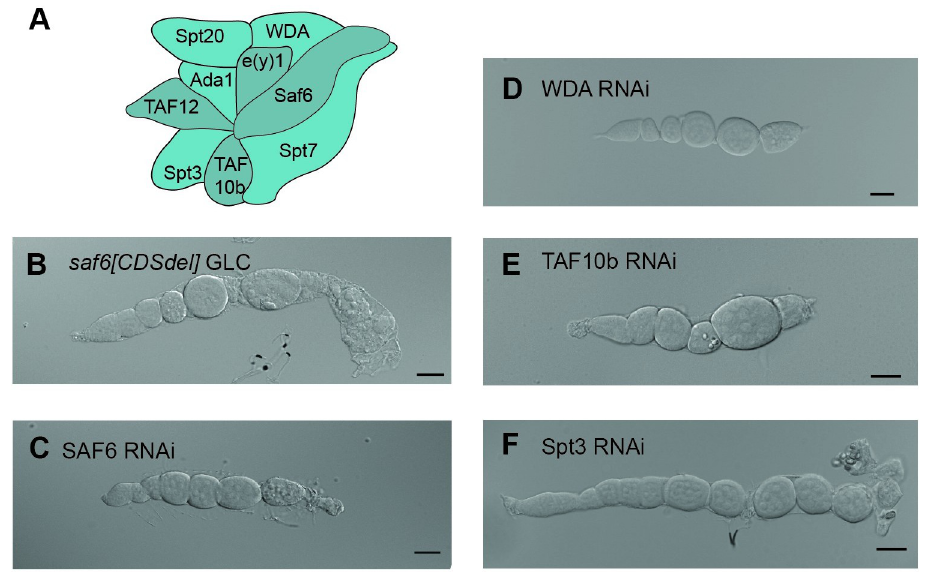
Fig 2. The core module of the SAGA complex is required for mid-oogenesis. (A) Overview of SAGA core subunits. (B) saf6[CDSdel] ovariole. (C) SAF6 RNAi ovariole. (D) WDA RNAi ovariole. (E) TAF10b RNAi ovariole. (F) Spt3 RNAi ovariole. Scale bar: 50 μ